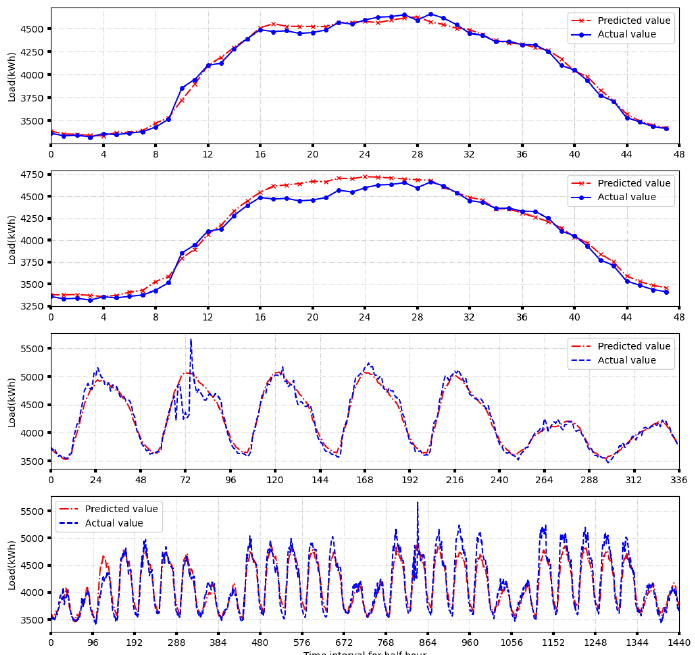
Figure 11. Prediction results for SVM in four prediction scenarios. Predicted and actual load demand in USTLP scenario for 21 September 2021 ( first row ); Predicted and actual load demand in STLP scenario for 21 September 2021 ( second row ); Predicted and actual load demand in MTLP scenario for the period 11 October 2021 – 17 October 2021 ( third row ); Predicted and actual load demand in LTLP scenario for the period 1 May 2021 – 30 May 2021 ( fourth row ). A typical day, week and month in the test dataset were selected for four prediction scenarios to show the results. Four subplots in Figures 10 and 11, from top to bottom, represent USTLP, STLP, MTLP and LTLL, respectively. It can be found from the two fig- ures that the discrepancy between the actual and predicted load demand becomes larger with a longer prediction time horizon, indicating a worse prediction performance. It can be concluded that both computational algorithms are more suitable for shorter time hori- zon load prediction. 4.3. Comparison of Prediction Performance for Two Algorithms The prediction result comparison and values of error indexes in the test dataset are shown in Figure 12 and Table 3. It can be found from the figure and table that the LSTM has a better prediction performance according to the USTLP and STLP scenarios, while the SVM achieves better prediction accuracy in MTLP and LTLP cases. Since the deeper network level can fit more non-linear relationships and LSTM can investigate the hidden information in time series data, LSTM performs better for shorter time horizon prediction. The worse prediction accuracy for LSTM in MTLP and LTLP cases is due to the size of the data. Big-size data in weeks or months make the LSTM challenging to capture data fea- tures. However, the better generalisation ability and the kernel function enable the SVM algorithm to jump out of the local minimal to achieve the optimal global solution, which results in SVM ’ s better prediction performance when facing larger-sized data [7]. Hence, to improve the LSTM accuracy in longer time horizon prediction scenarios, a deeper, more complex network (more nodes and more layers) needs to be established to enable LSTM to efficiently cope with larger data sizes. However, Table 1 shows that the epoch time in the LTLP case is 2085s, and the epoch time rapidly increases with the in- crease in data size, indicating that the exploration is limited by the existing computing